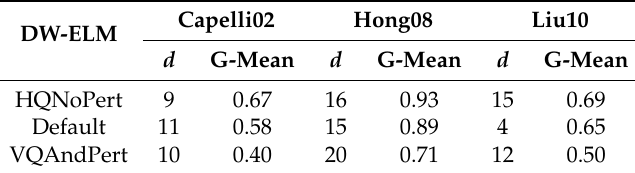
Table 3. Results of the G-means from the optimal decaying parameters in the testing stage for each studied databases and feature extractors.